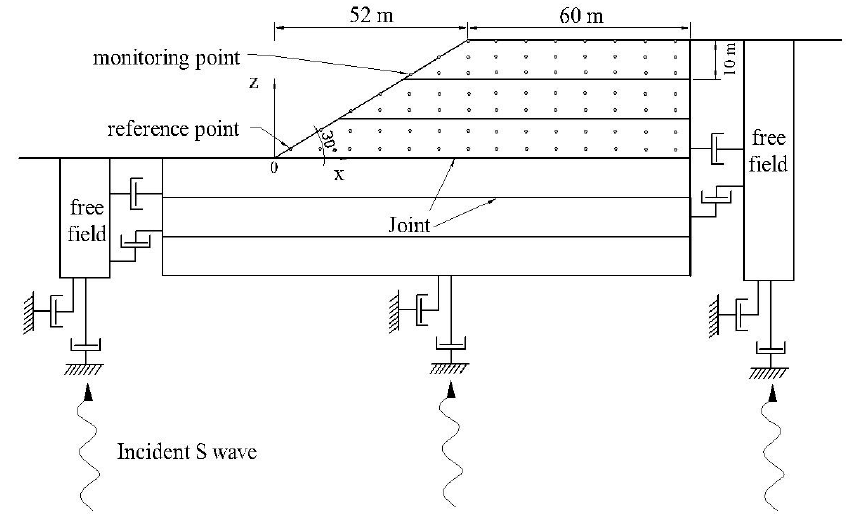
Figure 7. Schematic illustration of FLAC model for the numerical analysis.